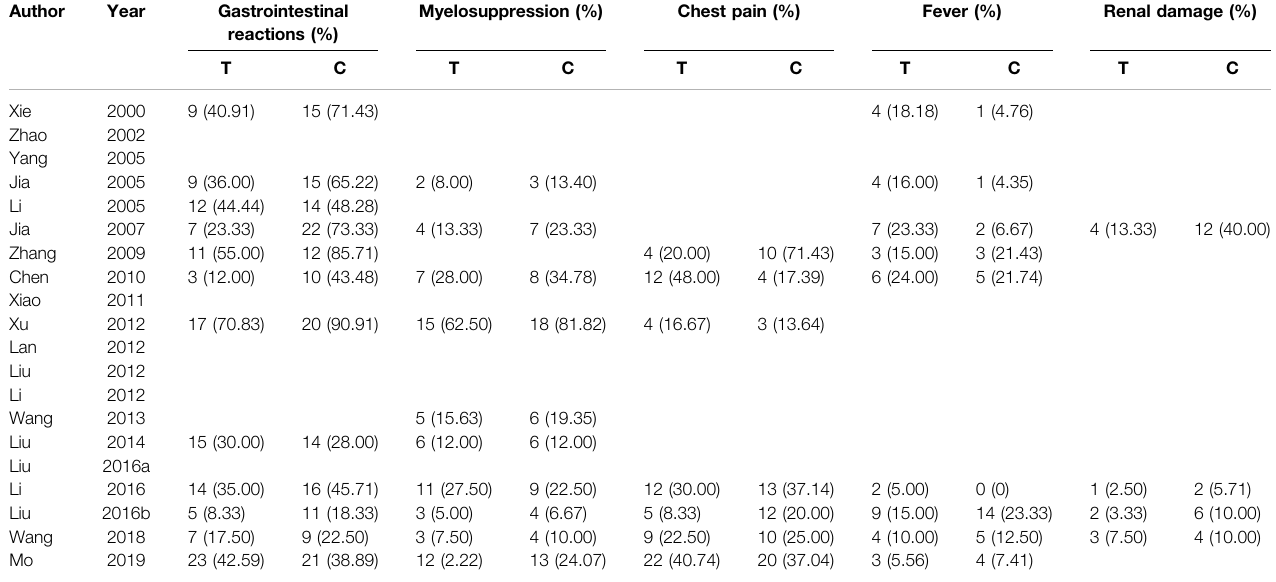
TABLE 3 | Comparison of adverse events between KLTI combined with chemotherapeutic agents versus chemotherapeutic agents alone.